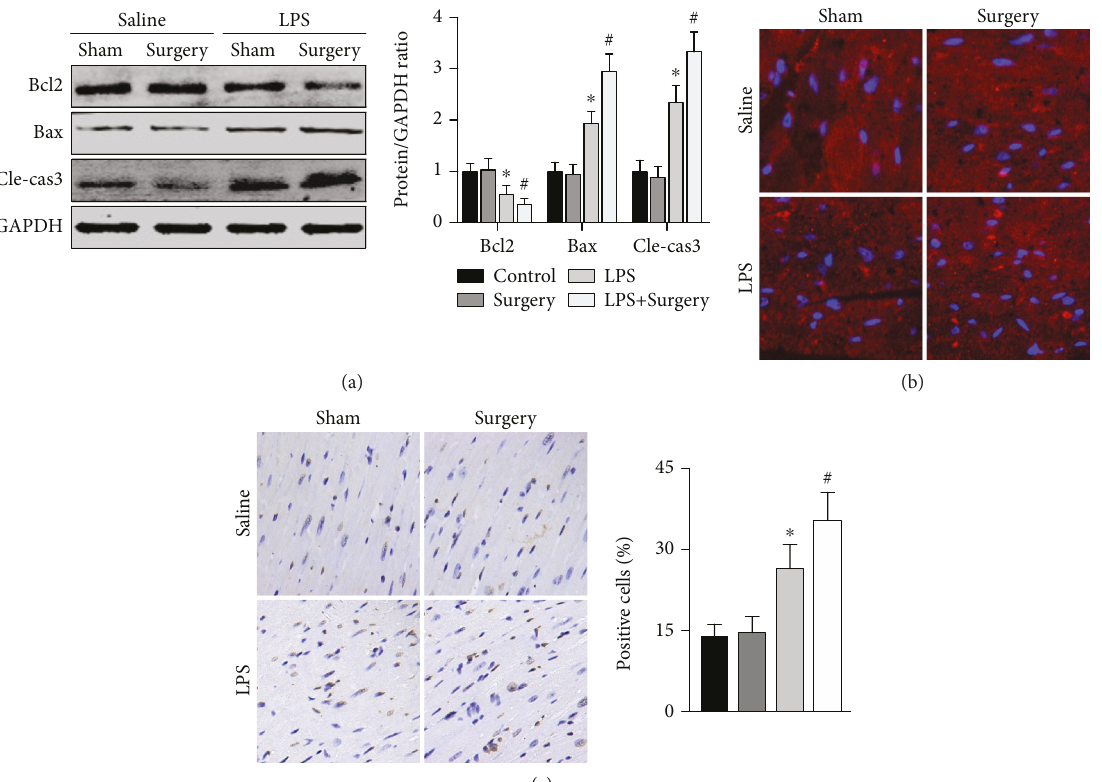
Figure 4: E ff ects of thyroidectomy on LPS-induced myocardial cell apoptosis in mice. (a) The Bcl2, Bax, and Cle-cas3 levels in each group were measured by western blot. (b) Heart Cle-cas3 levels were detected by immuno fl uorescence staining (200x). (c) Representative images of TUNEL staining and the quantitative results in each group (200x). N = 5 in each group. ∗ P < 0 05 vs. the control group. # P < 0 05 vs. the LPS